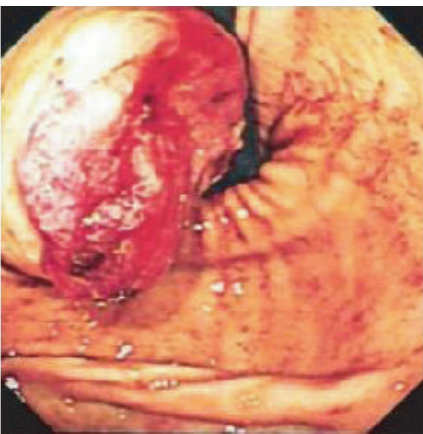
Figure 1: Findings at endoscopy. Note the large ulcerative gastric mass on the greater curve of the stomach.